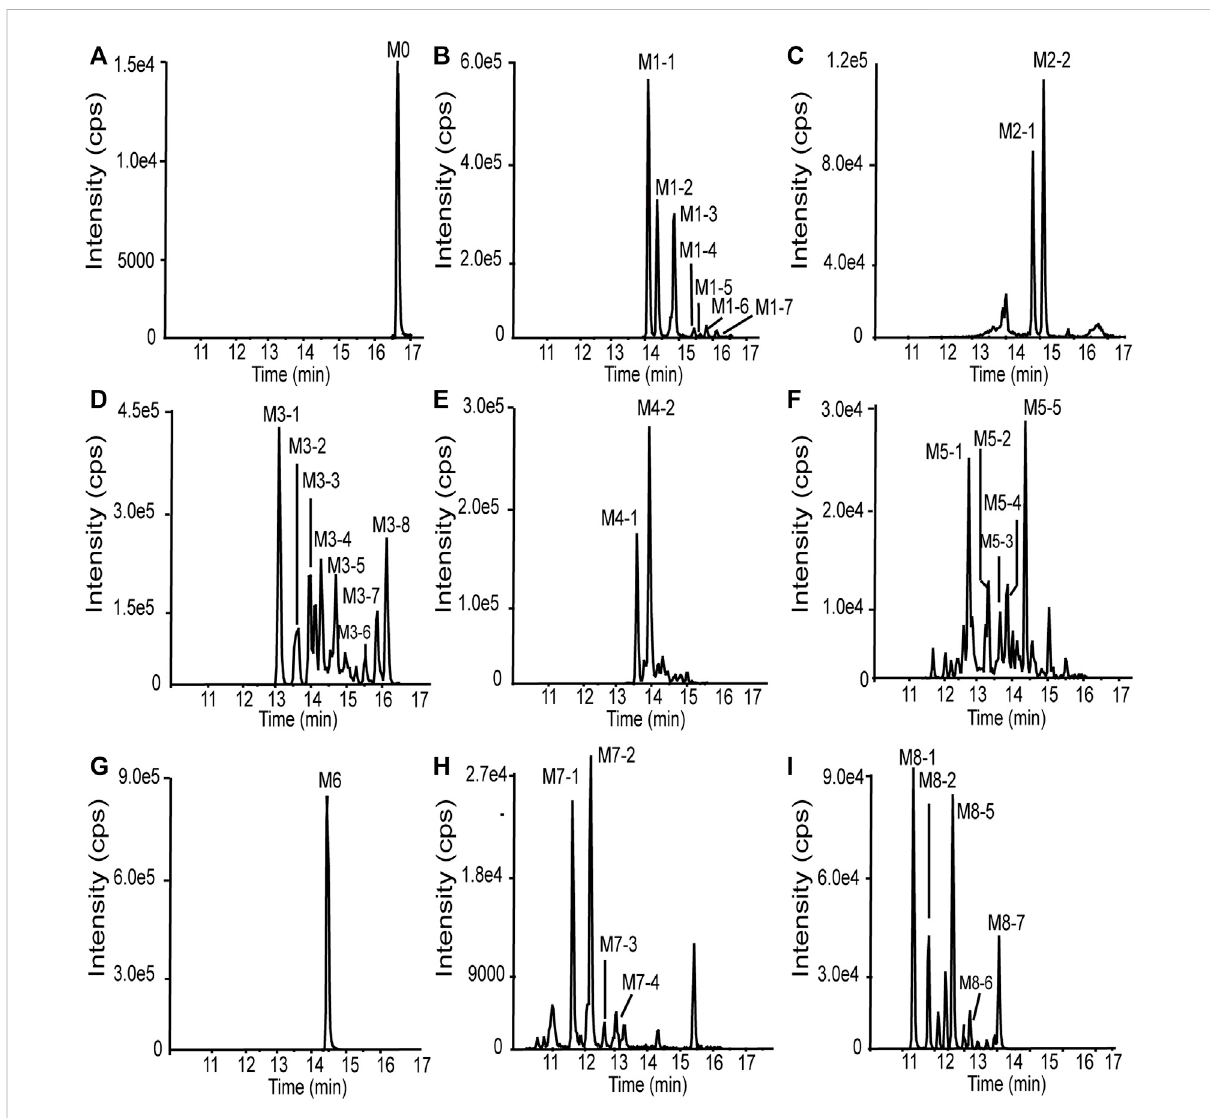
FIGURE 3 Extracted ion chromatograms of 101BHG-D01 and the metabolites in human liver microsomes. (A) M0 (101BHG-D01). (B) M1 metabolites. (C) M2 metabolites. (D) M3 metabolites. (E) M4 metabolites. (F) M5 metabolites. (G) M6 metabolite. (H) M7 metabolites. (I) M8 metabolites.